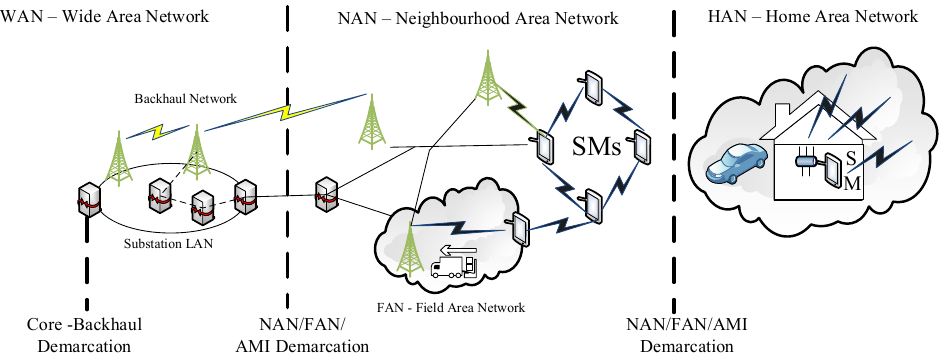
Figure 1 . Various segments of the smart grid (HAN, NAN, WAN) and the interconnectivity between them.